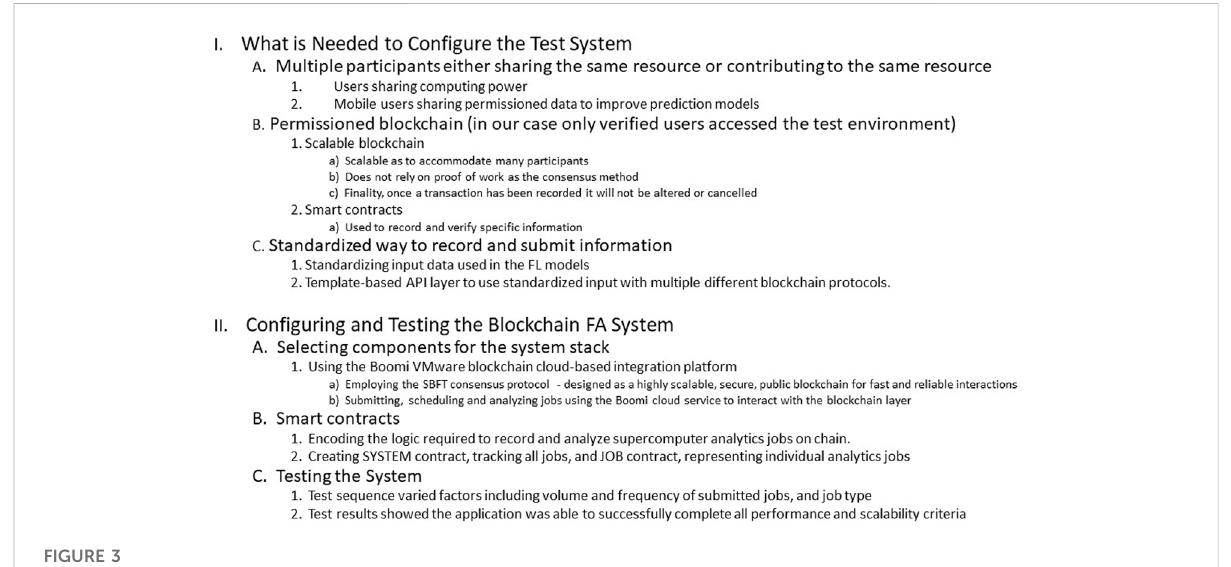
FIGURE 3 Design considerations in con fi guring an FA Blockchain